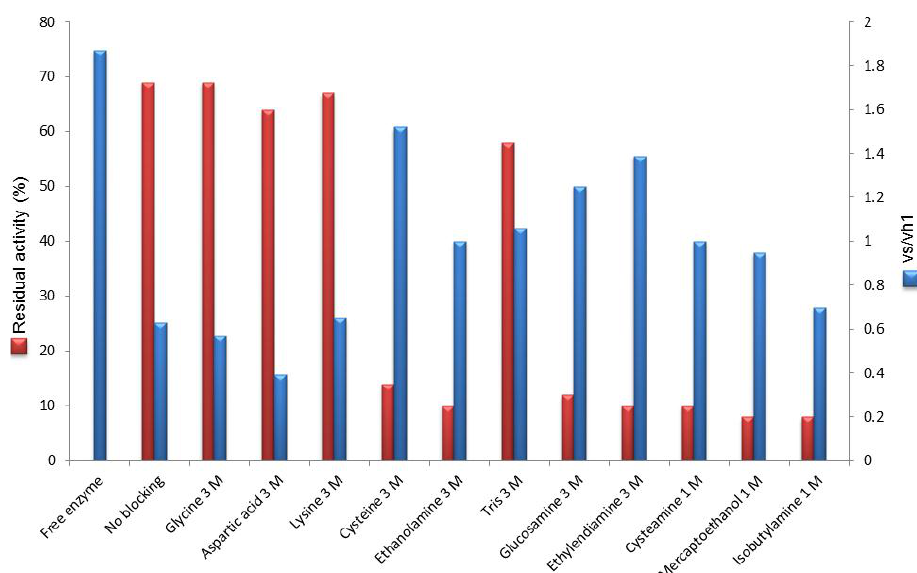
Figure 2. Residual activity and vs/vh post-immobilization quenching of unreacted